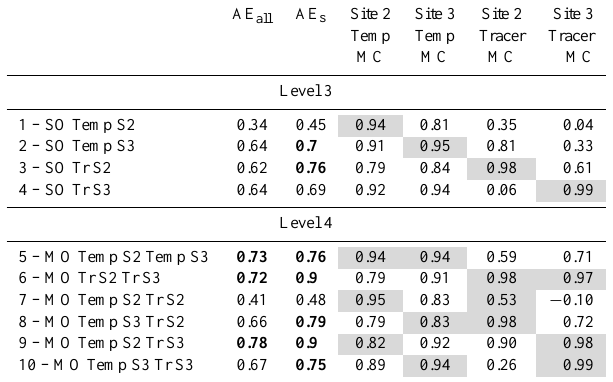
Table 5. Results for single objective (SO, Level 3, Tests 1–4) and multi-objective (MO, Level 4, Tests 5–10) calibration tests using